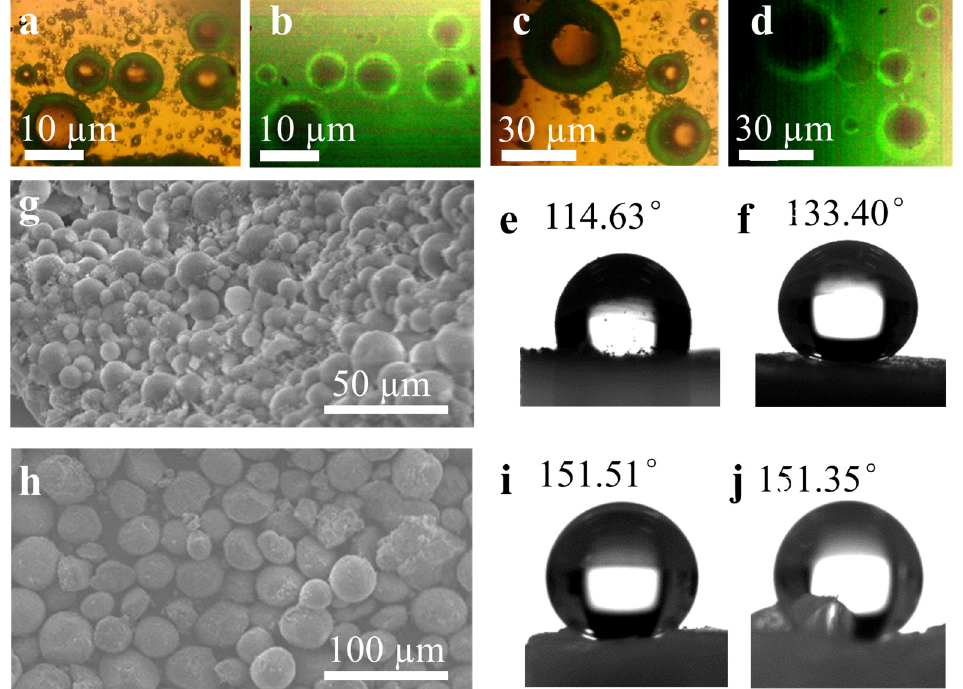
Figure 3. Optical microscope images of the core–shell structure of PDMS-wrapped SiO 2 aerogel microspheres of wg-SAMS-4.5@PDMS ( a , b ) and teos-SAMS-4.5@PDMS ( c , d ) under white light ( a , c ) and blue light ( b , d ) (480 nm), respectively. Photographs of water droplets on the samples of wg- SAMS-4.5@PDMS ( e ) and teos-SAMS-4.5@PDMS ( f ). SEM images of methyl-modified PDMS-